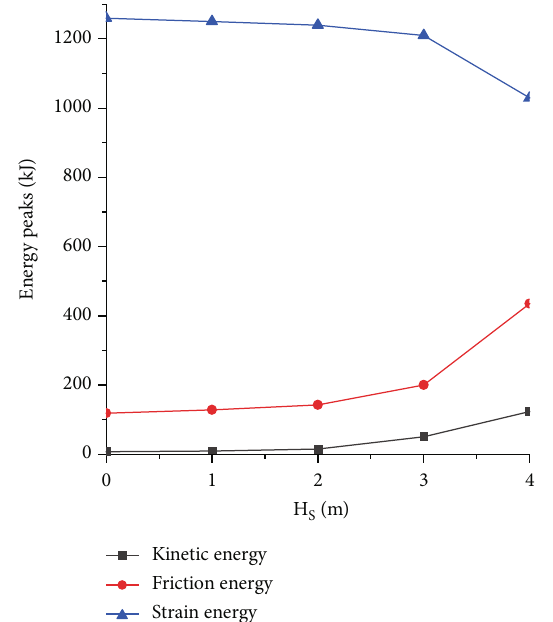
Figure 16: Curves of peak energy versus H